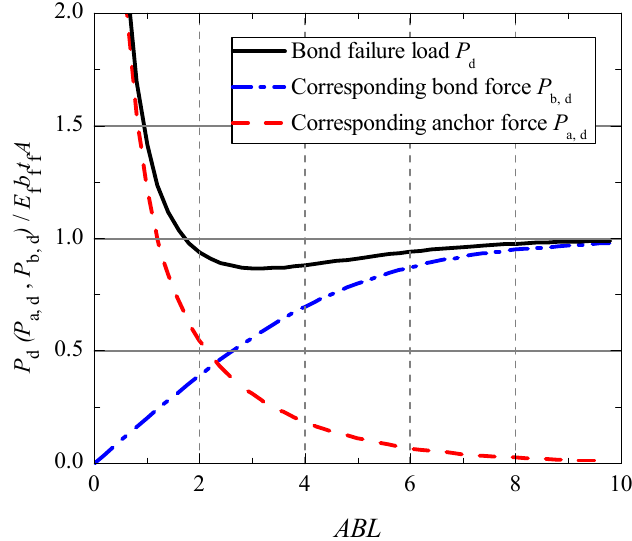
Figure 4. Relationship between P d ( P a , d , P b , d ) and bond length.